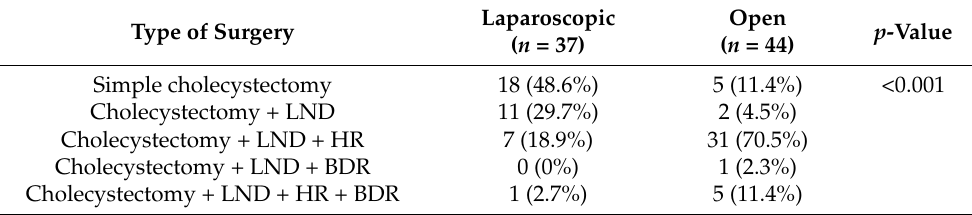
Table 2. Baseline characteristics of the patients.